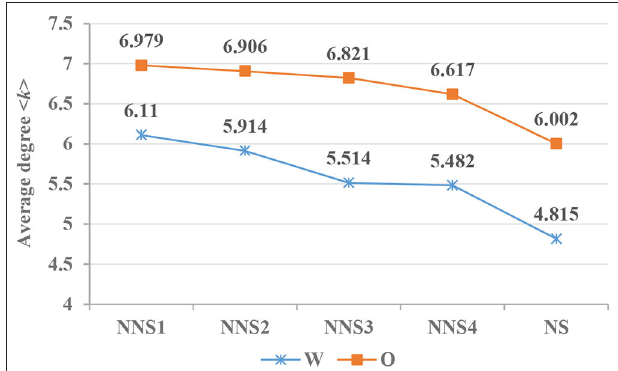
FIGURE 5 | Changes in < k > in CSL learners’ and native speakers’ syntax networks. NNS196NNS4, non-native speakers with low to high L2 language proficiency; NS, native